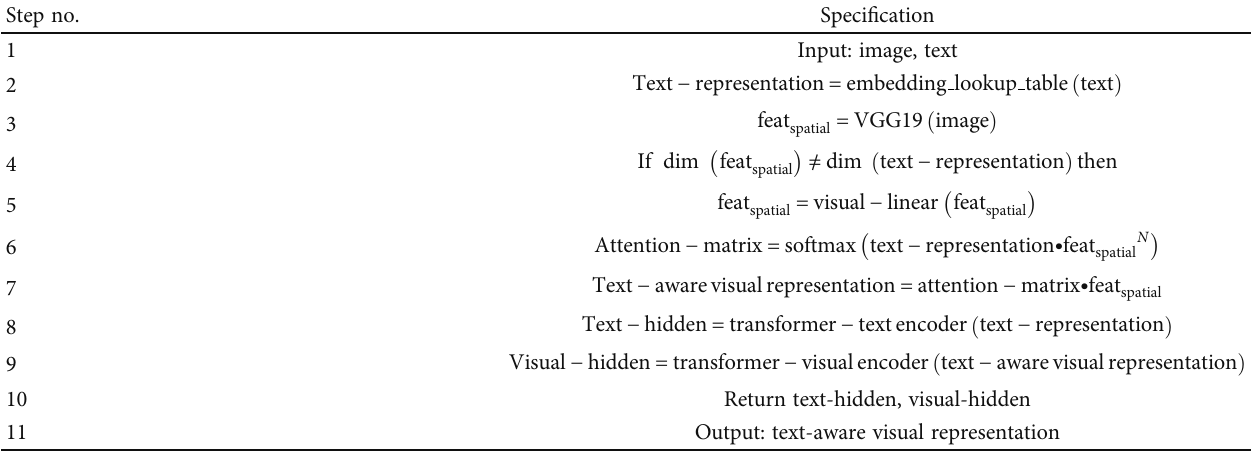
Table 1: Visual representation algorithm for generating perceptual